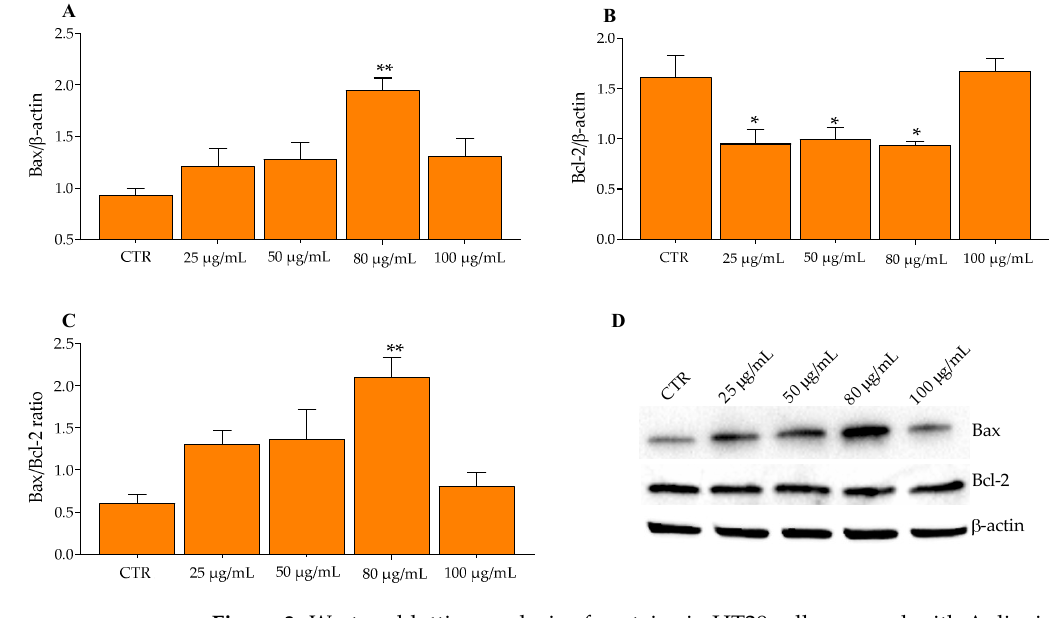
Figure 3. Western blotting analysis of proteins in HT29 cells exposed with Aglianico GP gastroin- testinal digested extract at increasing concentrations for 24 h. ( A ) Bax proteins; ( B ) Bcl-2 proteins; ( C ) Bax/Bcl-2 ratio; ( D ) Relative blots. All data represent the result of three different experiments (means ± SD). p -value was determined by ANOVA with Dunnett’s test. * p < 0.01 and ** p < 0.001.